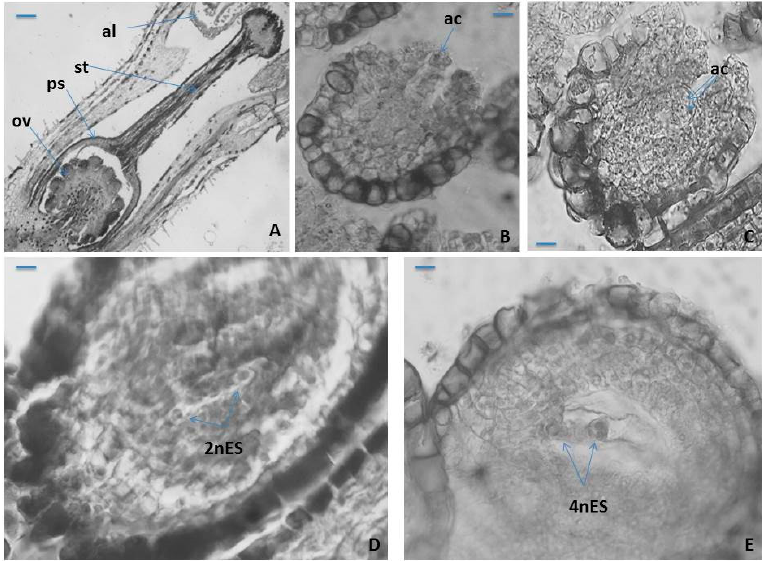
Figure 3. Ovule and female gametophyte development. ( A ) An ovary with ovules, style and stigma, ( B ) unicellular archesporium in a young ovule, ( C ) two-cellular archesporium in an ovule, ( D ) two-nucleate Polygonum -type ES and ( E ) Four-nucleate Polygonum -type ES. ov—ovule; ps—ovary; st—style; al—anther locule; ac—archesporium cell; mt—megaspore tetrad; 2nES—two-nucleate ES; 4nES—four-nucleate ES. Scale bar = 100 μ m ( A ); 50 μ m ( B , C ); 20 μ m ( D , E ).